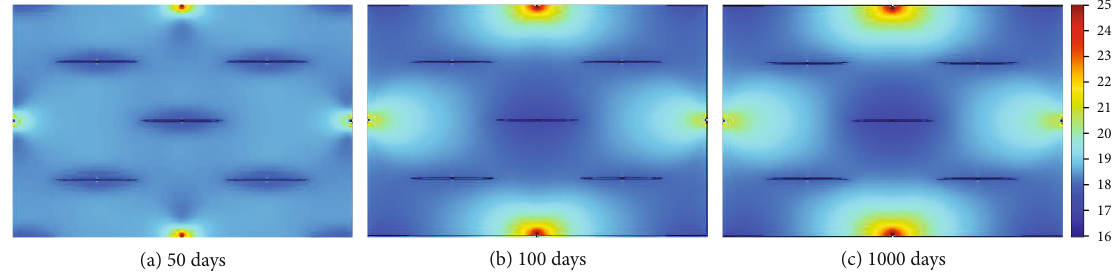
Figure 9: Maximum stress distribution in di ff erent development periods.